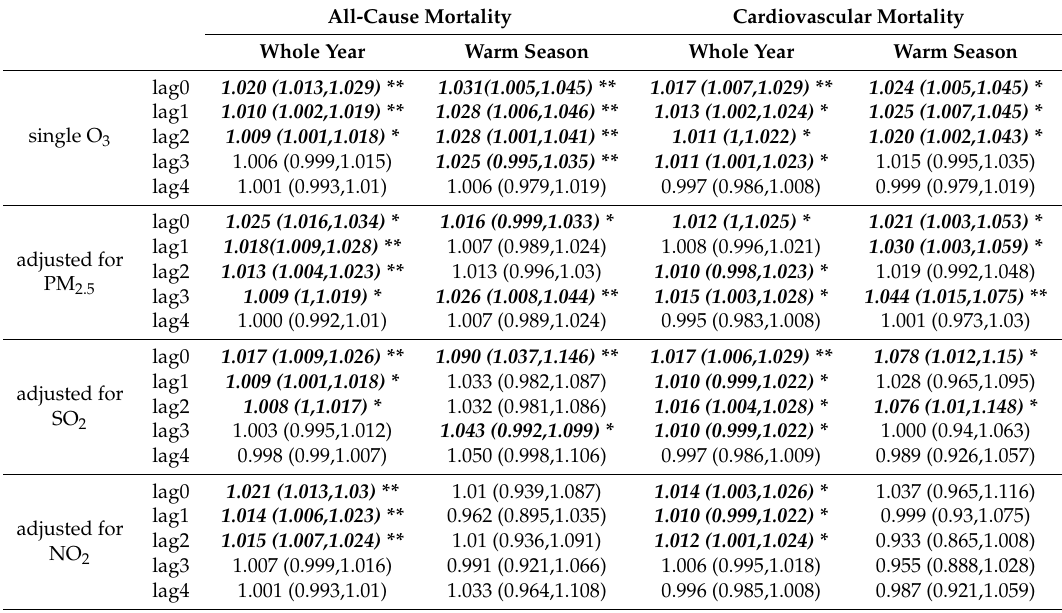
Table 2. Odds ratios for daily cause-specific mortality for a 10 µ g/m 3 increase in air pollutants. All-Cause